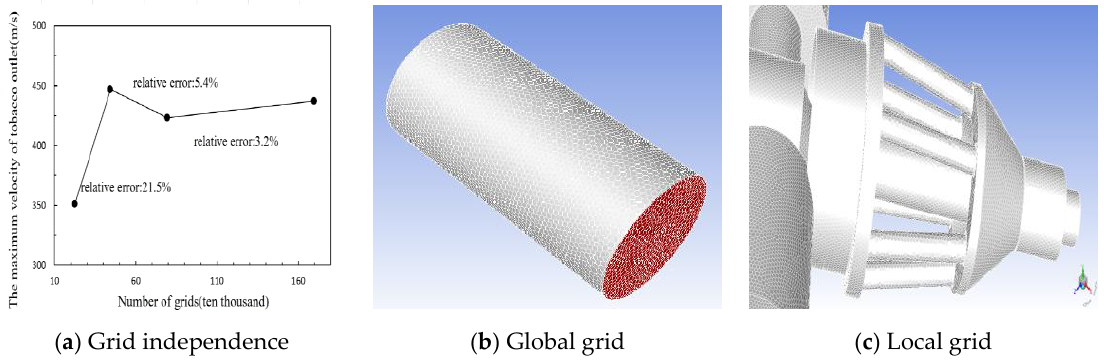
Figure 5. Grid independence verification.